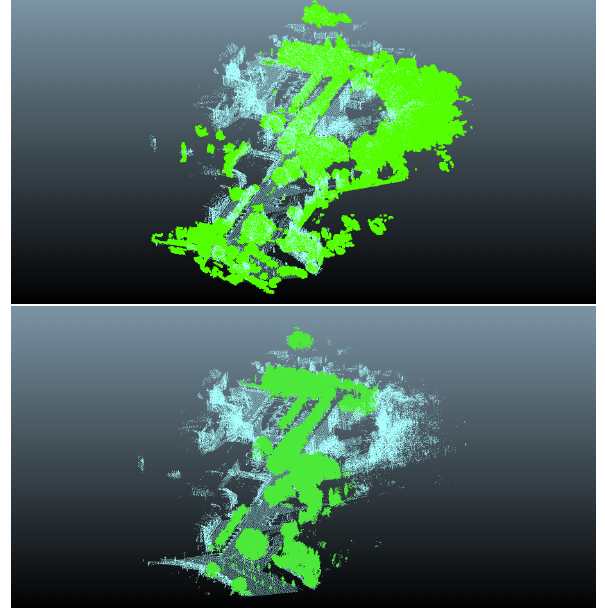
Figure 8: The intersecting AHN2 and MLS points are shown in the top and the bottom row respectively. The points which are classified as trees are shown in green.